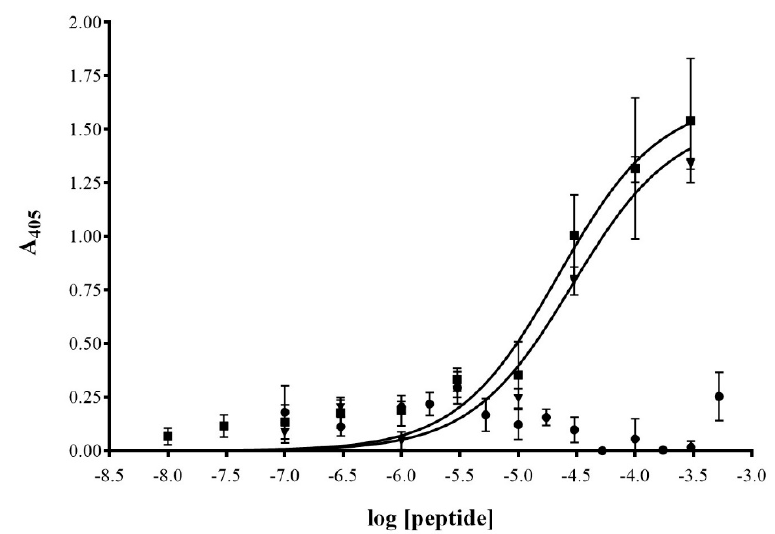
Figure 4. Binding properties of biotinylated peptides J18, J24, and N35 to ovarian carcinoma (SKOV-3) cells. Cells were grown to 80% confluency on 96-well plates and then incubated with varying concentrations (10 nM to 300 μ M) of J18 ( ■ ), J24 ( ▼ ), and N35 (•) for 1 h at 37 °C. Plates were washed with PBS and fixed with 10% formalin. Biotinylated peptides were detected by HRP-conjugated streptavidin and measurement of absorbance at 405 nM after the addition of HRP-substrate ABTS. EC50 values for J18 and J24 were calculated to be 22.2 ± 10.6 µ M, and 29.0 ± 6.9 µ M (mean ± SE), respectively. Measurements were performed on a µ Quant Universal Microplate Spectrophotometer (Winooski, VT,